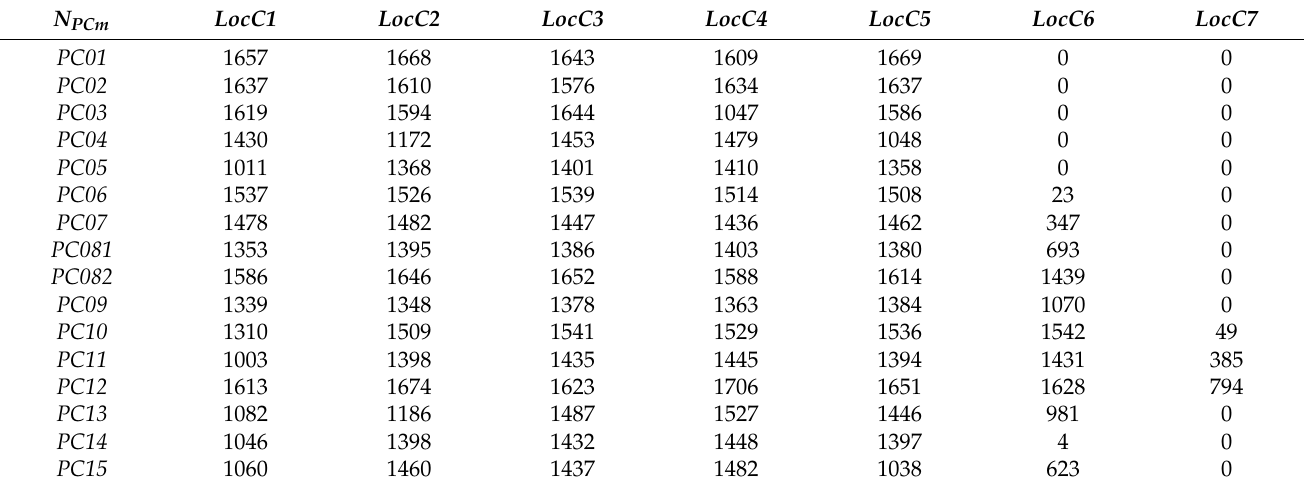
Table 4. The number of measurements for each location.